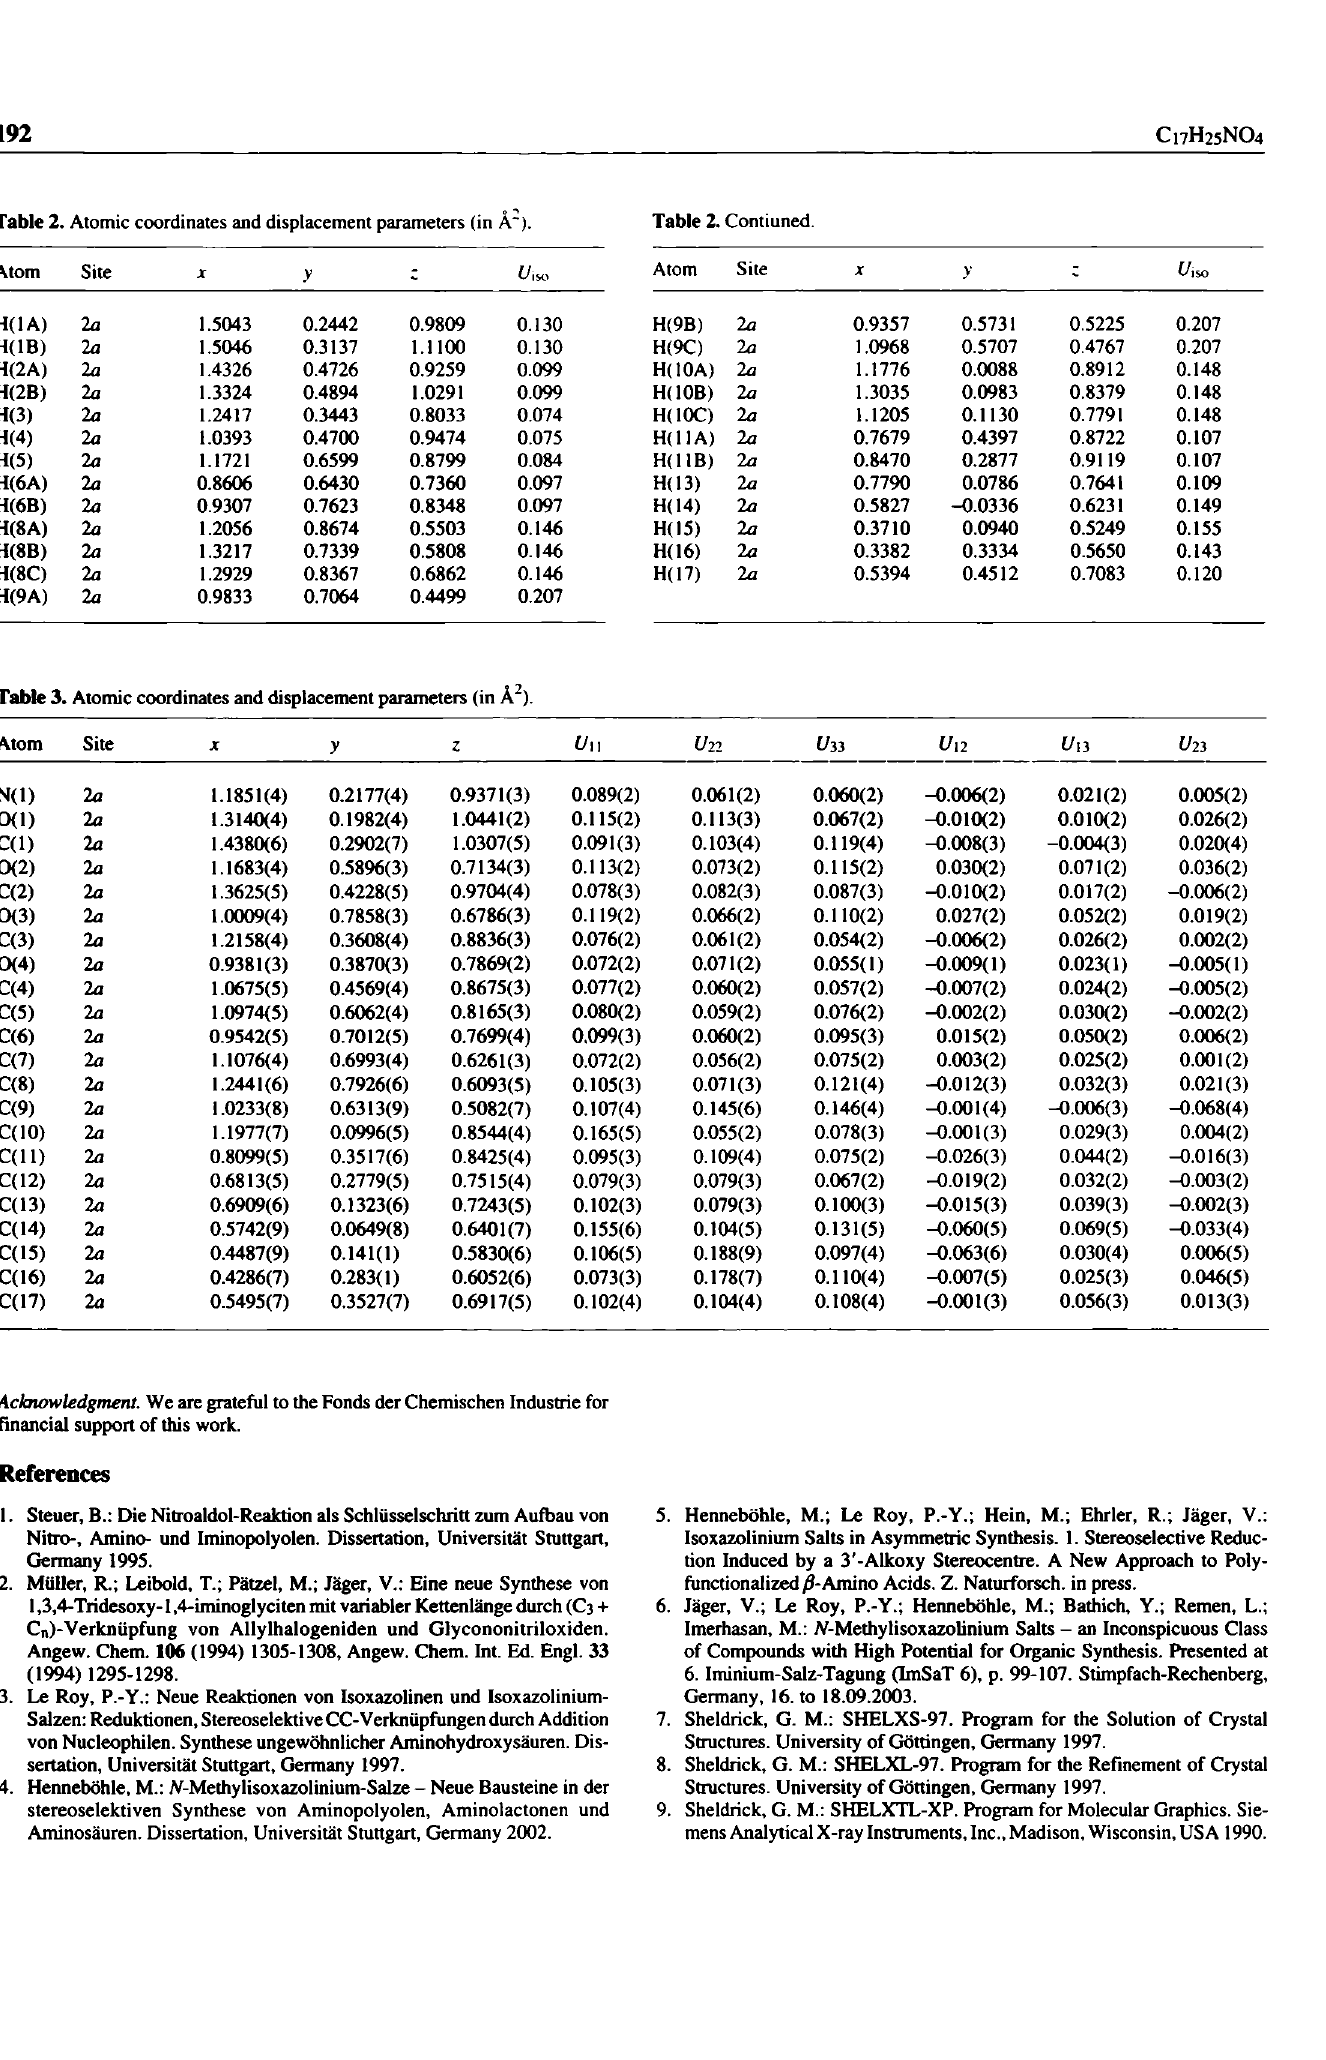
Table 3. Atomic coordinates and displacement parameters (in Â 2